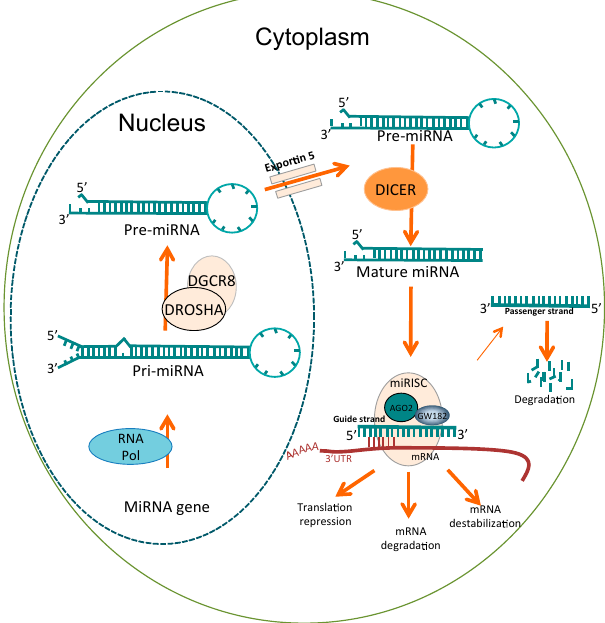
Figure 1. Biogenesis of miRNAs in the cell. miRNA precursors (pre-miRNAs) are transcribed in the nucleus and processed by the Drosha complex to generate pre-miRNAs. Pre-miRNAs are exported to the cytoplasm via exportin-5 and excised by DICER into a mature form of double-stranded RNA ~22 nt long. Double-stranded RNA is loaded onto AGO2 that is the catalytic component of the miRISC complex. One strand is removed from the duplex (the passenger strand) and the remaining RNA strand (the guide strand) binds to complementary sequences typically located in the 3’ untranslated region (UTR) of target mRNAs to repress translation or trigger mRNA